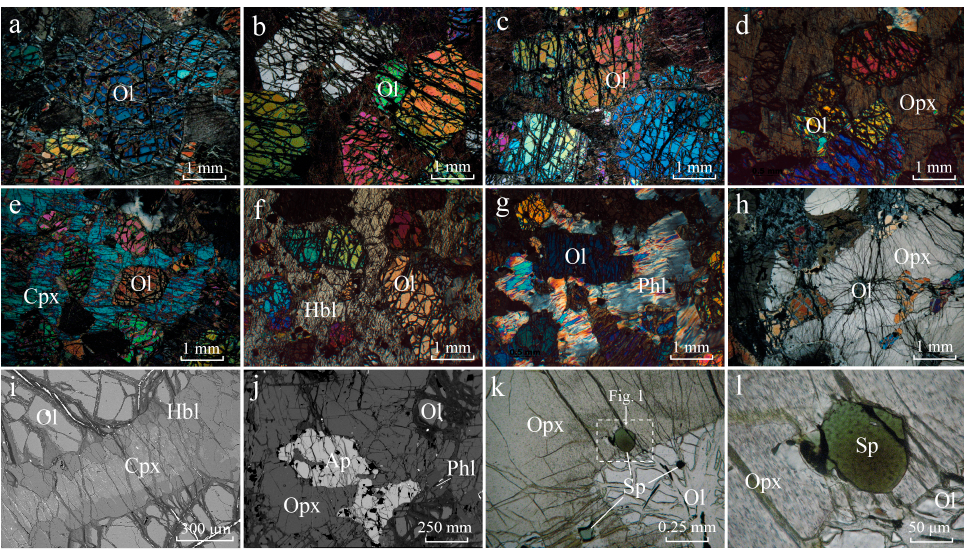
Figure 2. Polarized optical images and back-scattered electron images of ultramafic suits: ( a – c ) Olivine (Ol) occurring as cumulate crystals and partially serpentinized; ( d ) Olivine crystals surrounded by enstatite (Opx); ( e ) Olivine crystals surrounded by diopside (Cpx); ( f ) Olivine surrounded by tschermakite (Hbl); ( g ) Olivine surrounded by phlogopite (Phl). ( h ) Enstatite-hosted olivine with radial fractures. ( i ) Resorption-induced rim of tschermakite around diopside ( j ) Chlorapatite (Ap)–phlogopite pairs; ( k ) Three different appearances of Cr-spinel (Sp) in enstatite and olivine under polarizing microscope; ( l ) Zoned Cr-spinel under a polarizing